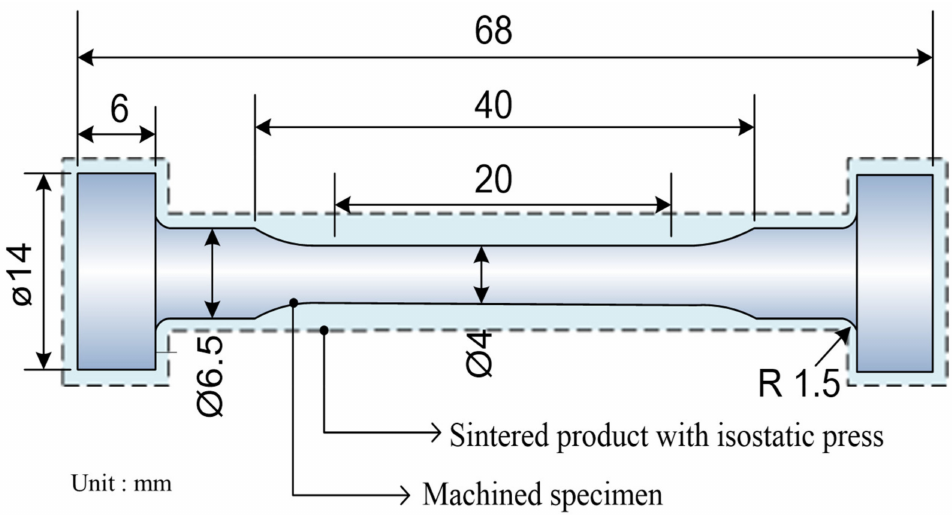
Figure 1. Dimensions of specimen for high-strength tensile